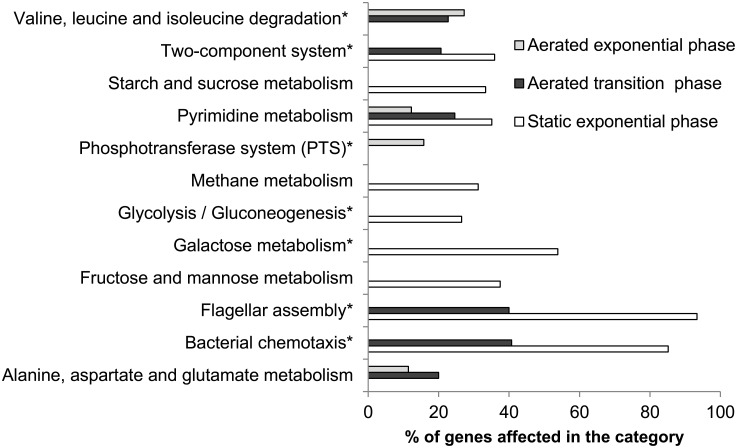
Affected metabolic pathways.Overrepresented metabolic pathways significantly down regulated in ΔrpoN. Outcome of FIVA analysis of significantly affected genes. Categories with asterisk (*) were restored to close to WT condition by complementation.